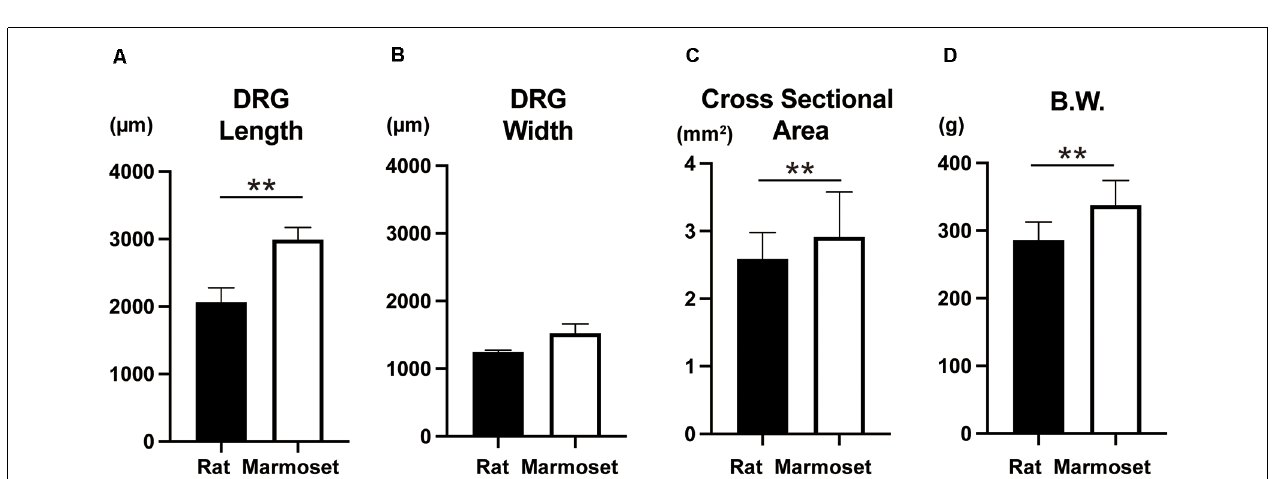
FIGURE 4 | Whole DRG size and body weight. Comparison of the whole DRG length (A) , width (B) , cross-sectional area (C) , and body weight (D) between rats ( n = 8) and marmosets ( n = 4 for A , B , C and n = 12 for D ). ** p < 0.01.